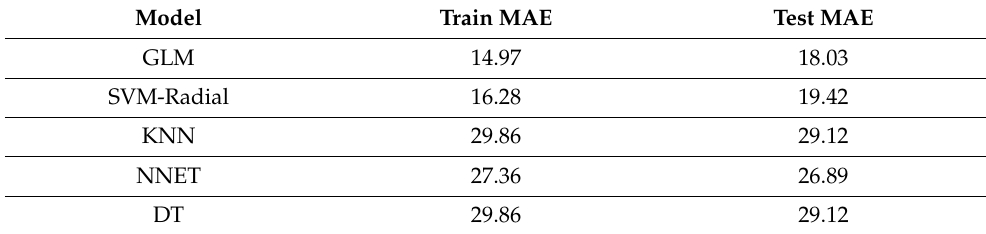
Table 10. Layer-2 Models Performance (IEEE 118-Bus System).